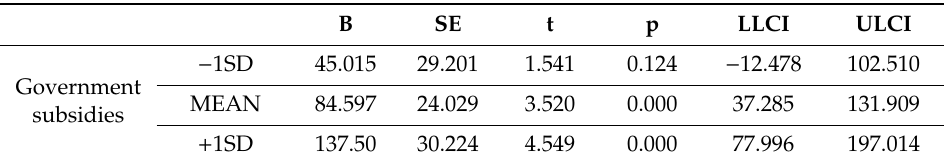
Table 5. Conditional effect of government subsidies.